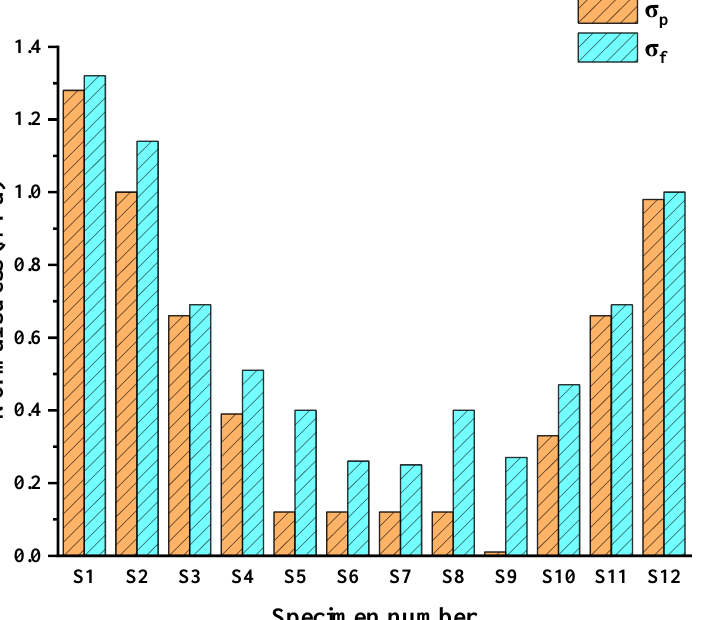
Figure 12. Theoretical normal stress σ p and actual normal stress σ f of unloading failure.